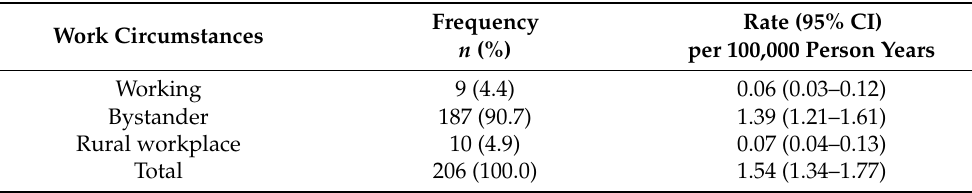
Table 1. Work circumstance of work-related fatal injuries to children (0–14 years), New Zealand, 1999–2014.